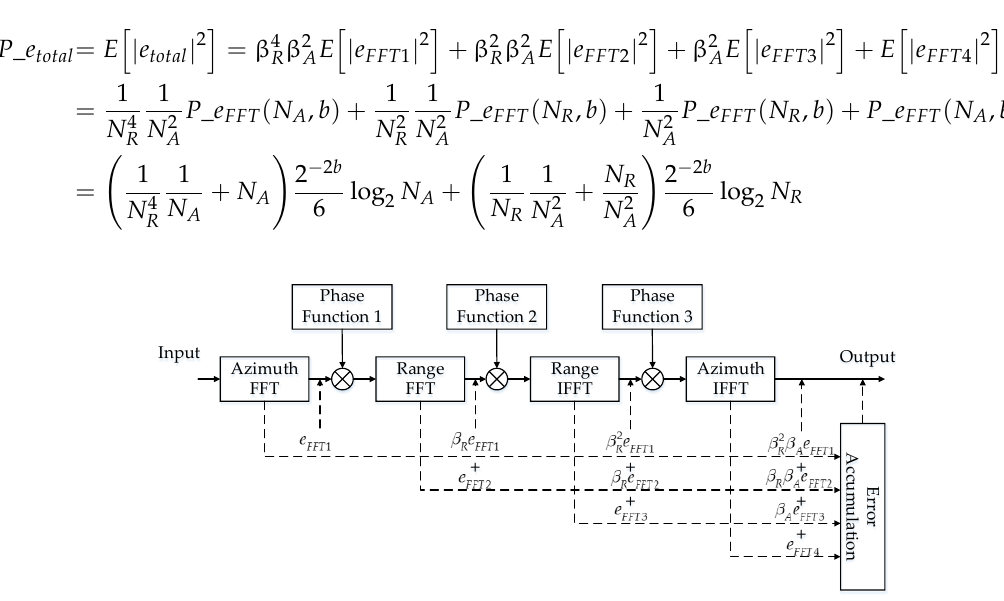
Figure 2. Proposed quantization error propagation model for CS algorithm.